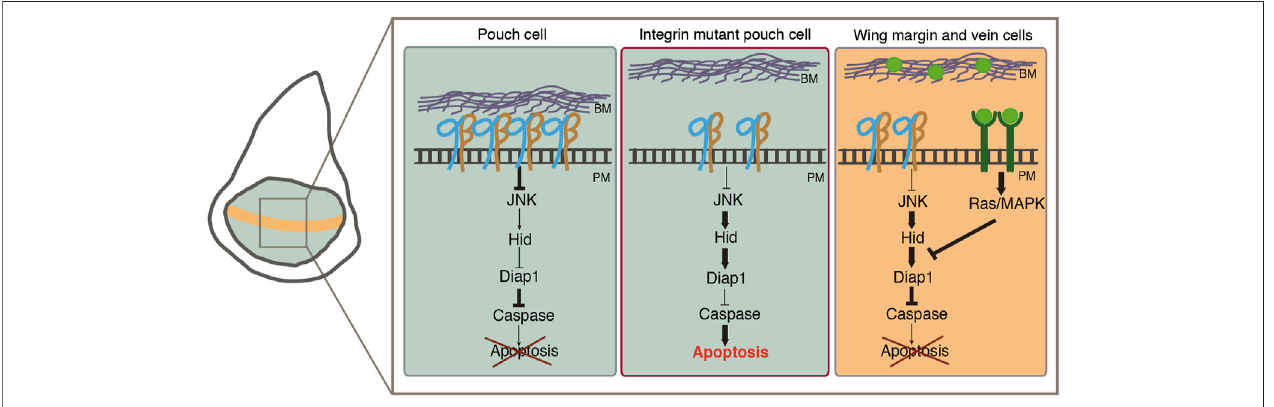
FIGURE 8 | Model showing how integrins and the EGFR pathway act together to promote cell survival in wing imaginal disc cells. On the left, schematic representation of a wing disc with the wing pouch colored in green and the wing margin in orange. On the right, proposed molecular mechanism by which integrins regulate cell survival. (Left rectangle) In pouch wing imaginal disc cells, integrin-mediated adhesion to the ECM regulates cell survival by repressing the expression of the pro-apoptotic gene hid via inhibition of JNK activity. (Middle rectangle) In the absence of integrins JNK activity levels increase leading to high levels of Hid expression, caspase activation and apoptosis. (Right rectangle) The EGFR (green) pathway prevents the death of wing margin and vein cells when they detach from the ECM during wing morphogenesis.